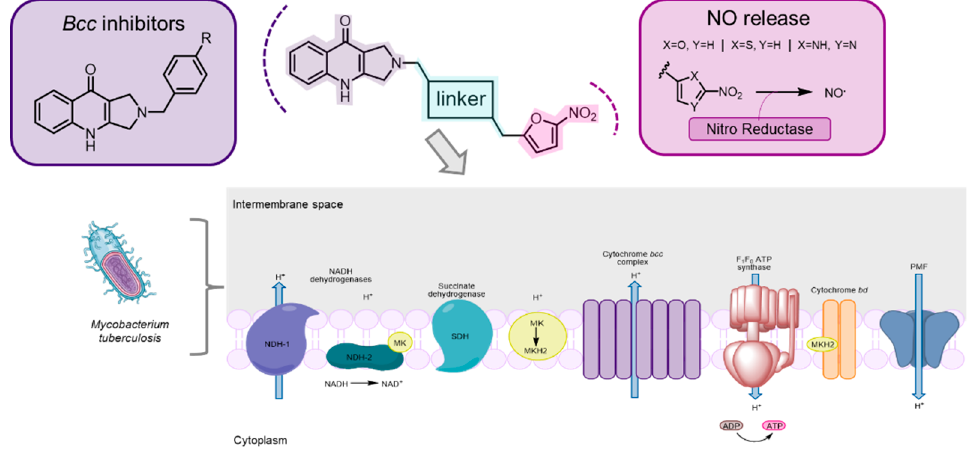
Figure 1. Structure of the anti-TB multitargeting Figure 25. Structure of the anti-TB multitargeting compounds.